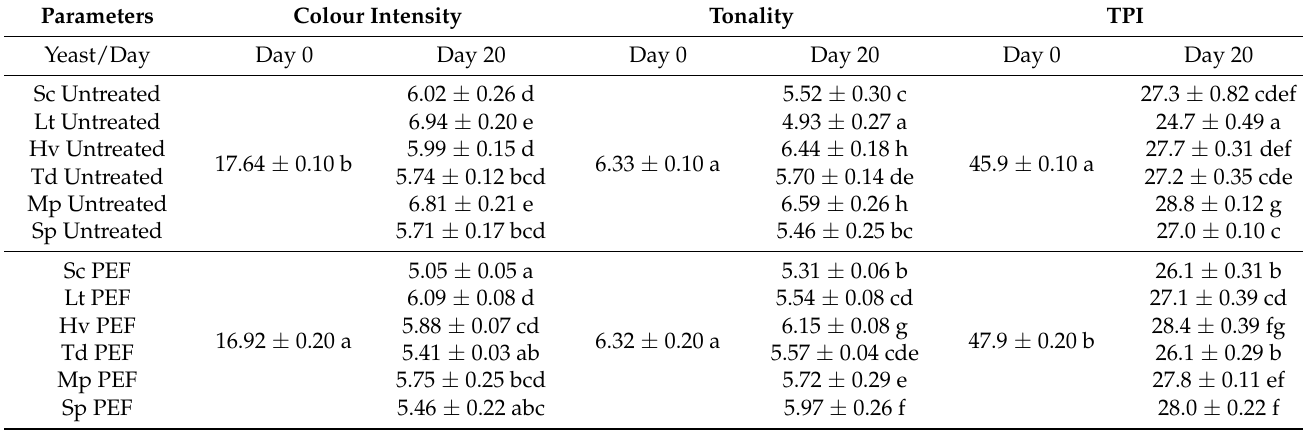
Table 3. Parameters of colour intensity, tonality and total polyphenols index (TPI) measured before inoculation (day 0) and on the last day of fermentation (day 20). Values are means ± sd ( n = 3). A different letter for the same day means significant differences ( p <